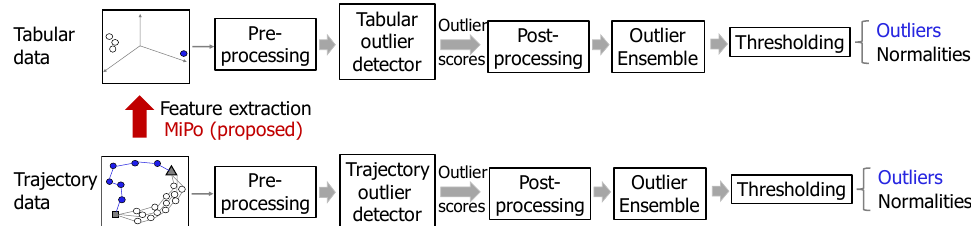
Figure 2. Typical outlier detection process for tabular ( top ) and trajectory data ( bottom